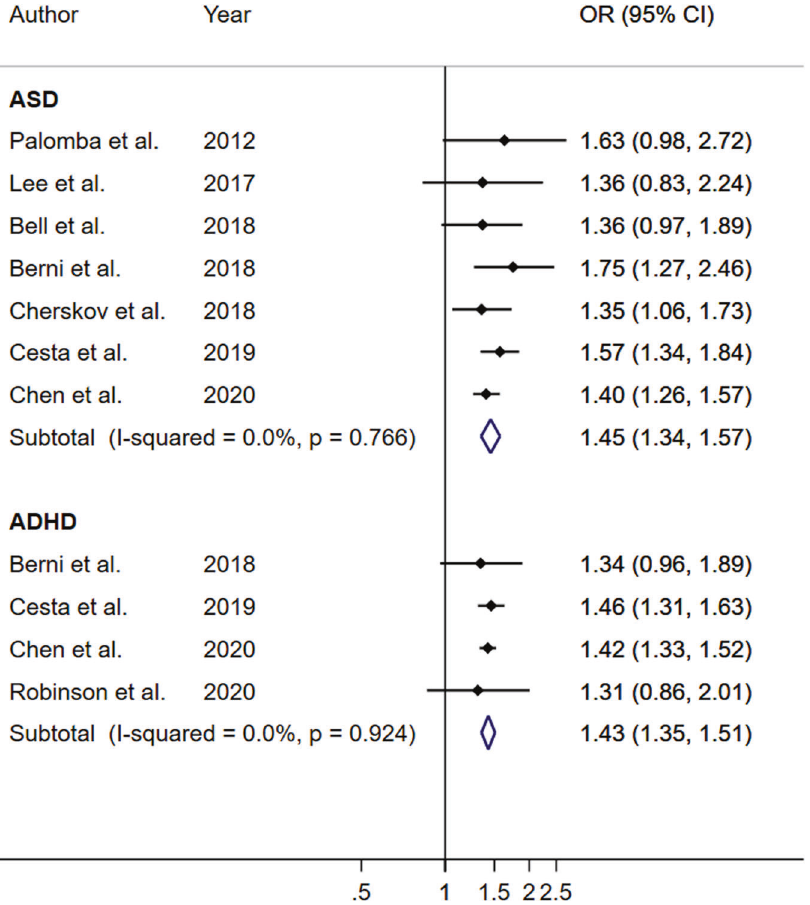
Fig. 2 Maternal PCOS on the development of ASD and ADHD in children using the analysis of cohort studies. PCOS polycystic ovary syndrome, ASD Autism spectrum disorder, ADHD Attention de fi cit hyperactivity